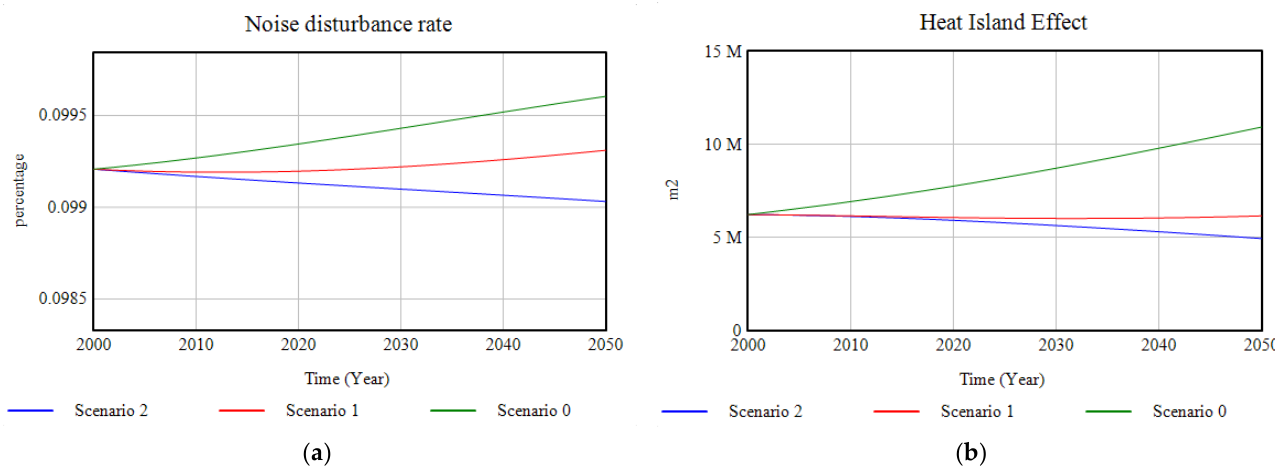
Figure 20. ( a ) Graphic representation of the noise disturbance rate; ( b ) graphic representation of the results of the modelling of the heat island effect for the cases of study, in the period 2000–2050.